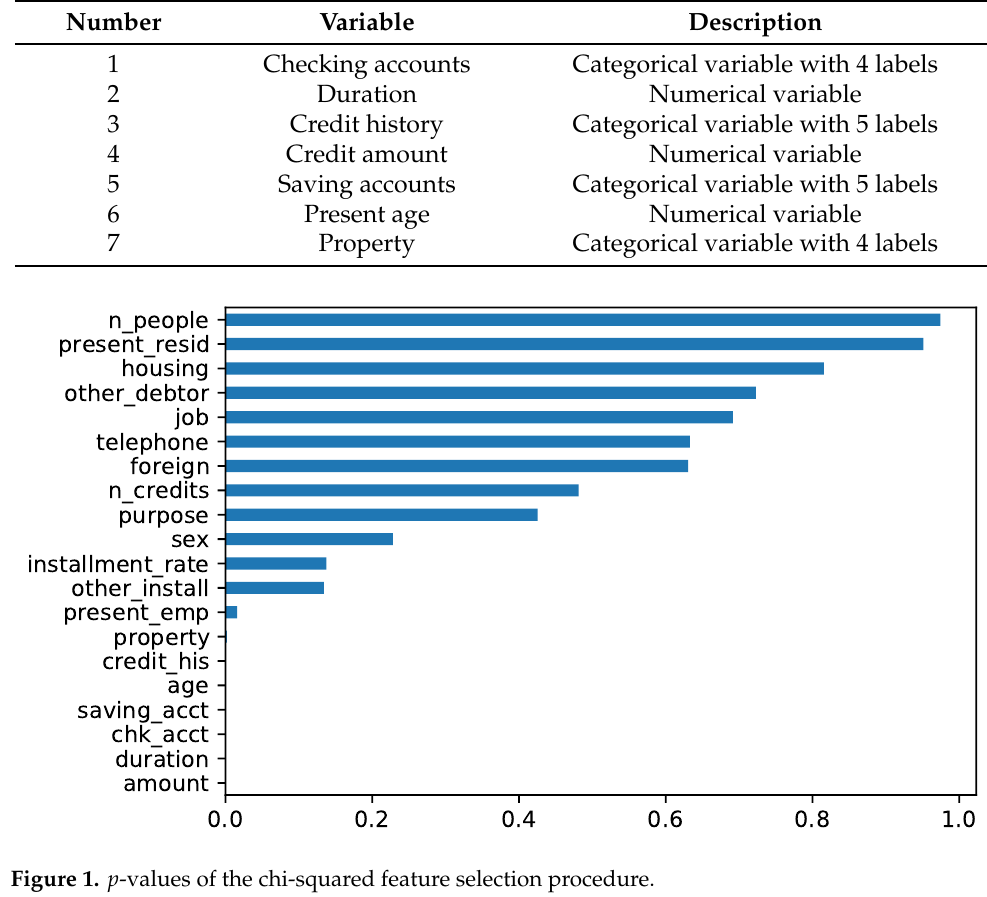
Table 3. Variables selected via chi-squared feature selection.